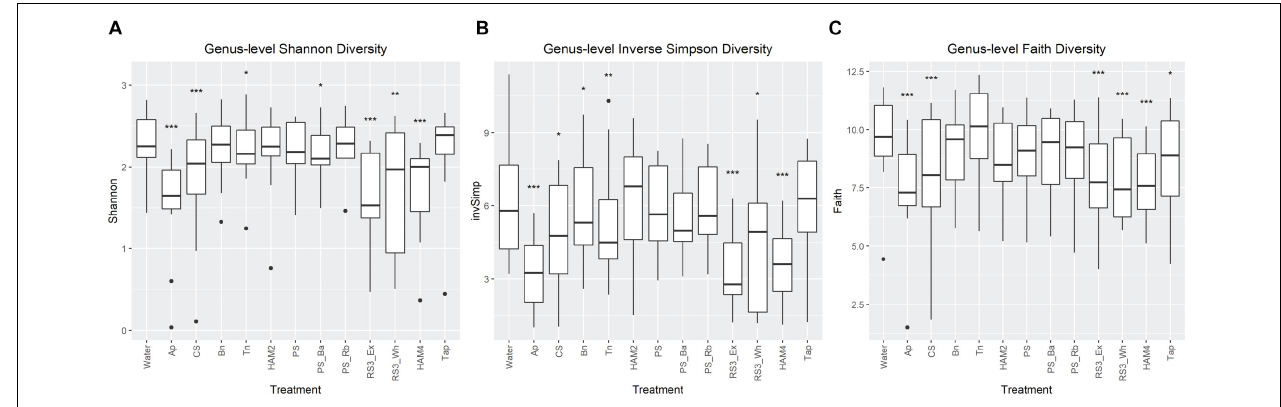
FIGURE 3 | Comparison of genus-level alpha diversity metrics between treatments. Shannon diversity (A) and inverse Simpson diversity (B) and their significant differences between the treatments no-carbohydrate added control (labeled as Water) were calculated via the DivNet package in R. Faith’s Phylogenetic Diversity (C) was calculated via the Picante package in R and significant differences determined via a linear mixed effects model. All significant differences were calculated as comparisons to the control with FDR correction. Labels are * P < 0.05, ** P < 0.01, *** P < 0.001. Ap, amylopectin; CS, corn starch; Bn, green banana flour; Tn, tiger nut flour; HAM2, high amylose maize starch; PS, potato starch; PS_Ba, potato starch with fecal samples supplemented with Bifidobacterium adolescentis ; PS_Rb, potato starch with fecal samples supplemented with Ruminococcus bromii ; RS3_Ex, retrograded extracted potato starch; RS3_Wh, retrograded whole potatoes; HAM4, chemically cross-linked high amylose maize starch; Tap, chemically cross-linked tapioca starch.